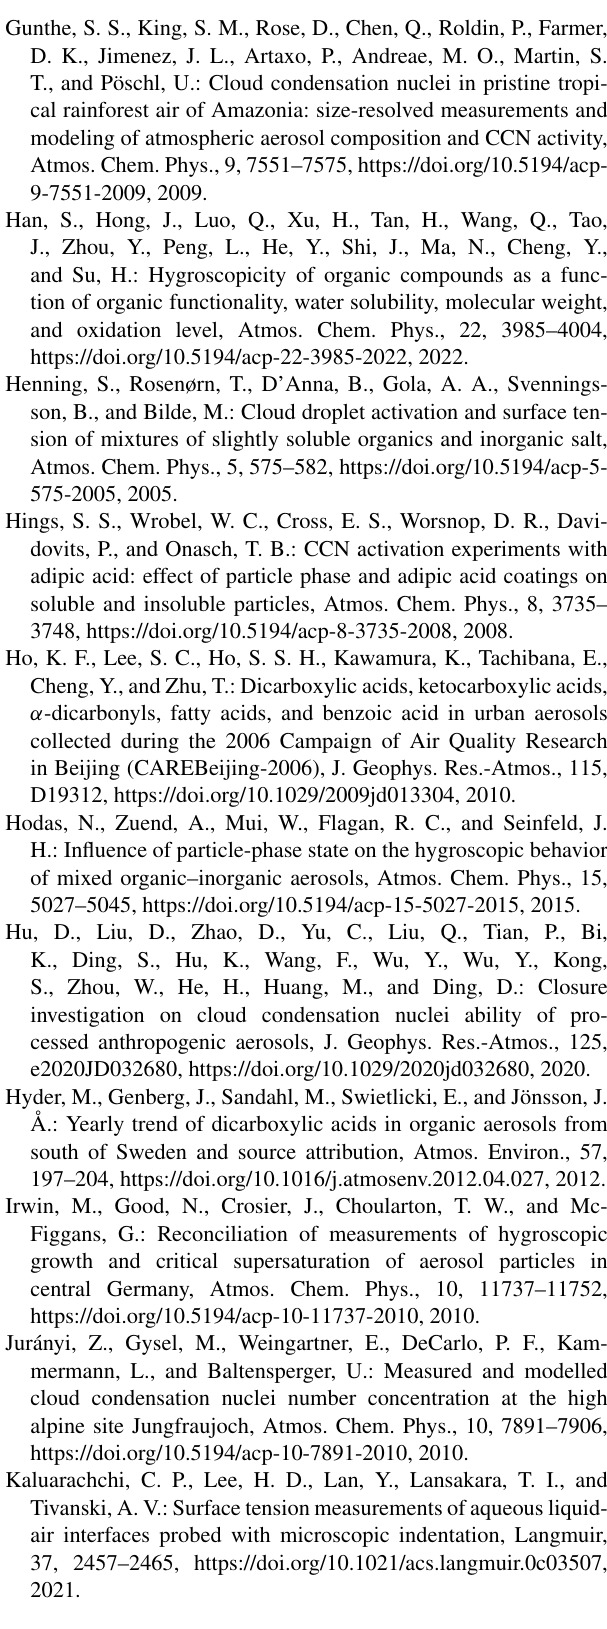
Figgans, G.: Reconciliation of measurements of